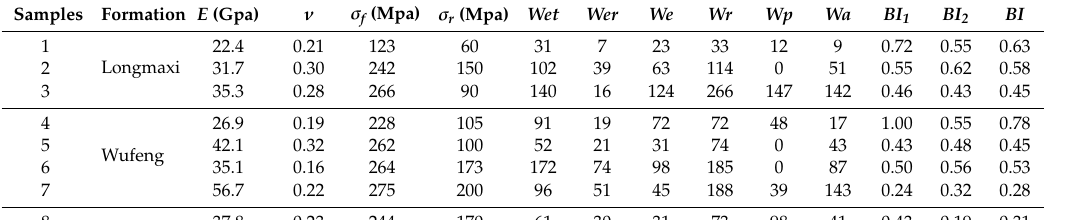
Table 2. Summary of mechanical parameters obtained from complete stress-strain curves of tested